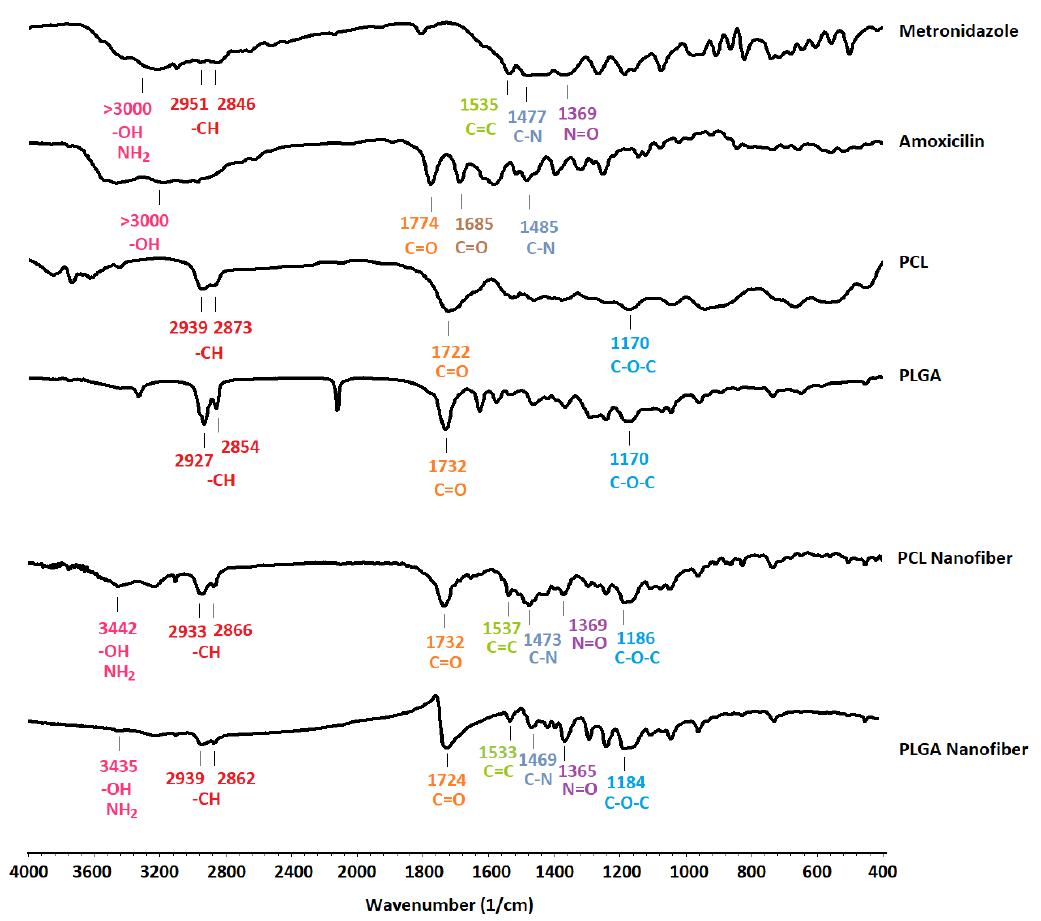
Figure 2. FTIR spectra and characteristic peaks of metronidazole, amoxicillin, PCL, PLGA, and the formulated nanofibers.